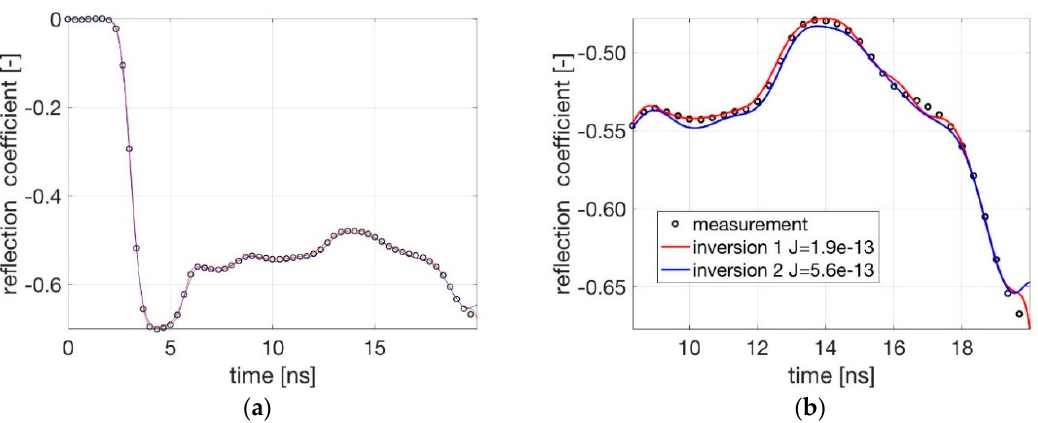
Figure 9. Comparison between measured and inverted reflected signals. ( a ) Whole signal; ( b ) Enlarged